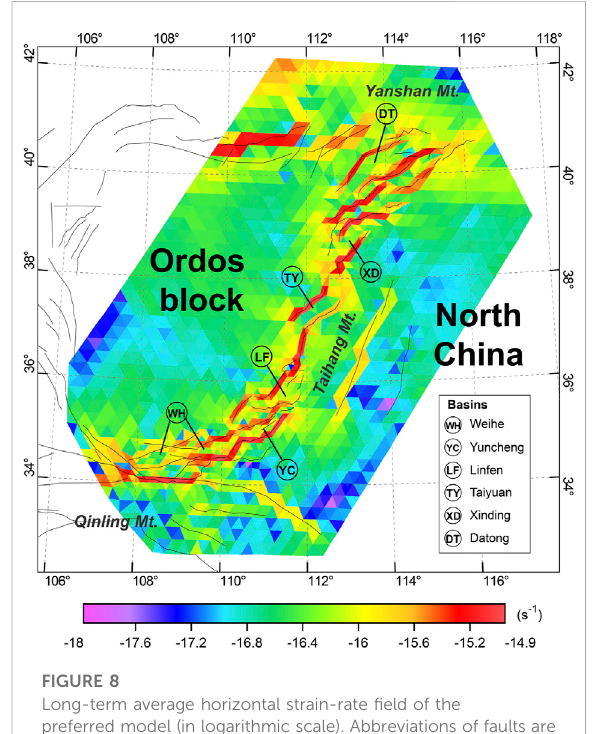
FIGURE 8 Long-term average horizontal strain-rate fi eld of the preferred model (in logarithmic scale). Abbreviations of faults are given in Figure 1.